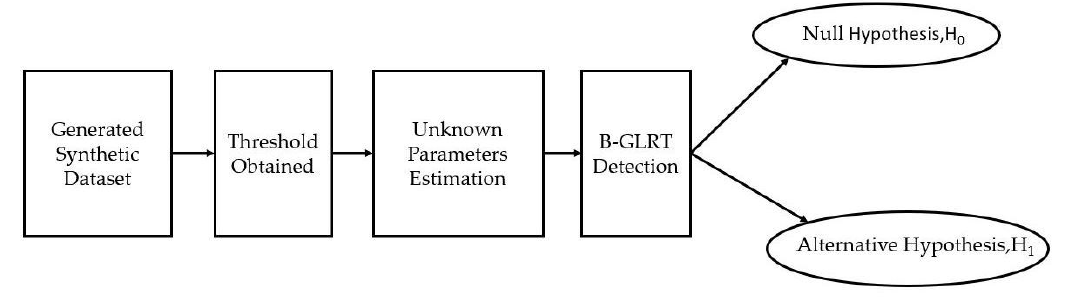
Figure 2. Algorithm